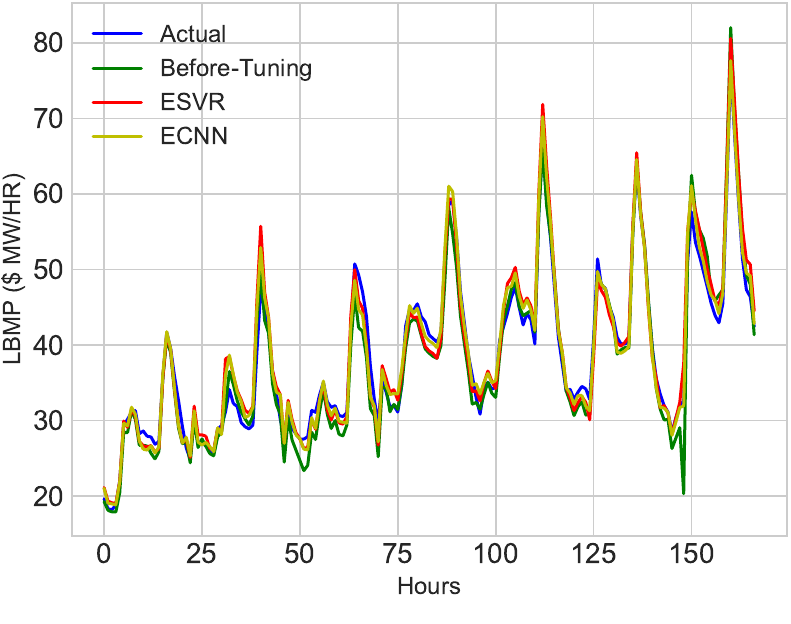
Figure 21. First Week of January, 2017.